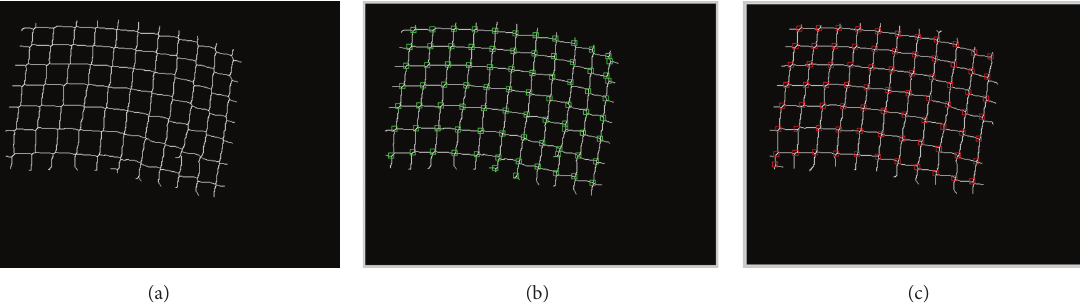
Figure 9: (a) An skeleton left image after thinning, (b) detected intersection points plotted on a left image, and (c) detected intersection points plotted on a right image.